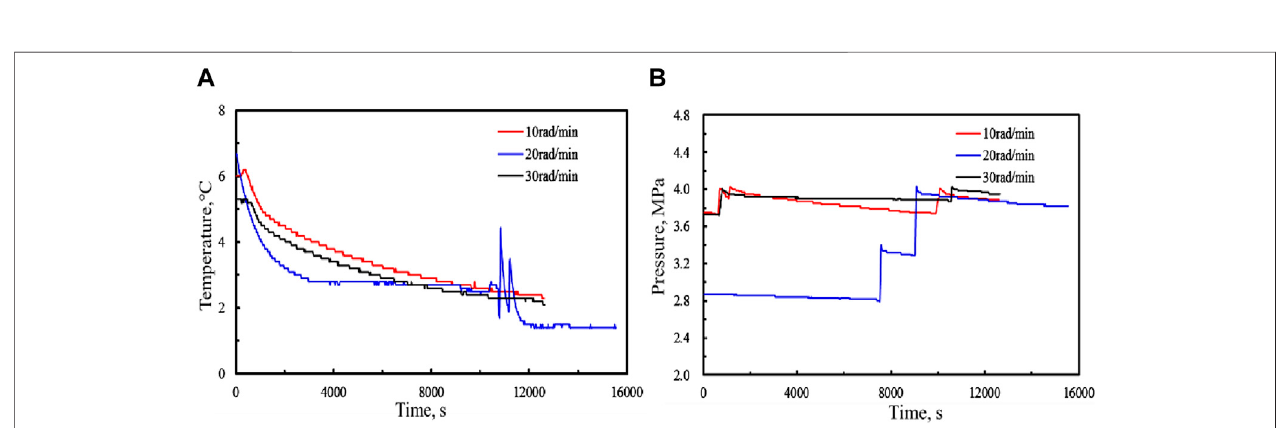
FIGURE 4 | Temperature and pressure comparison curves of methane hydrate formation process at different rotating speeds. ( A :Temperature; B :Pressure).